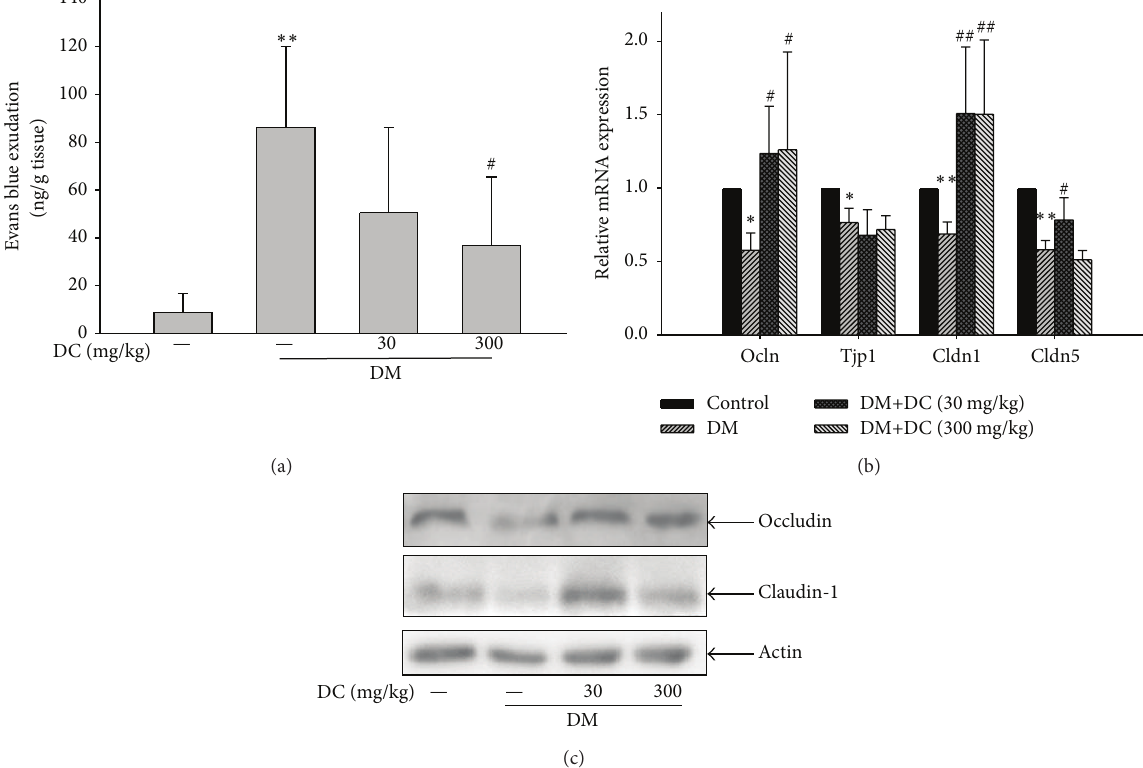
Figure 2: (a) Quantitative results of retinal blood vessel leakage by Evans blue dye. Data are expressed as means ± SD ( 𝑛 = 6 ). ∗∗∗ 𝑃 < 0.001 compared to control; ### 𝑃 < 0.001 compared to DM without DC. (b) Retinal mRNA expression of occludin (Ocln), ZO-1 (Tjp1), claudin-1 (Cldn1), and claudin-5 (Cldn5). Data are expressed as means ± SD ( 𝑛 = 10 for control, 𝑛 = 7 for DM, 𝑛 = 9 for DM+DC 30mg/kg, and 𝑛 = 8 for DM+DC 300 mg/kg). ∗ 𝑃 < 0.05 , ∗∗ 𝑃 < 0.01 compared to control; # 𝑃 < 0.05 , ## 𝑃 < 0.01 compared to DM without DC. (c) Retinal protein expression of occludin and claudin-1 is detected by immunoblotting using specific antibodies. The occludin protein represents four independent experiments, and claudin-1 protein represents two independent